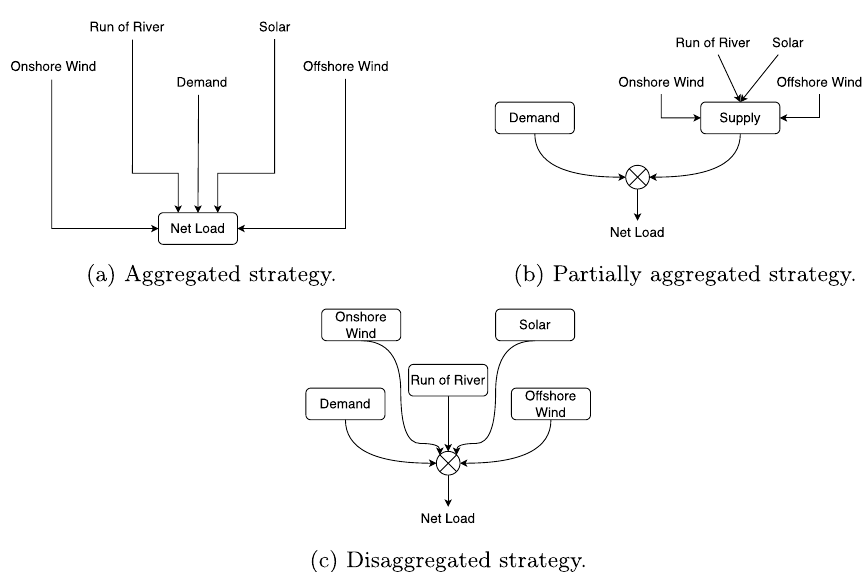
Fig. 1 Representation of the different strategies for forecasting net load, where each box represents a forecasting model and ⊗ represents the combination of forecasting